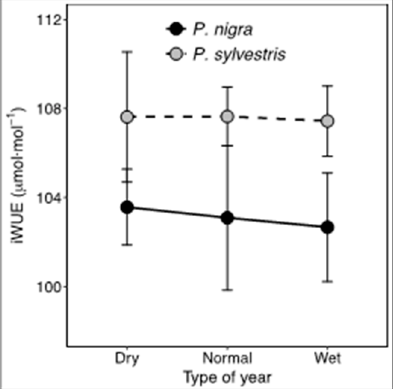
Figure 6. Mean intrinsic water use efficiency (iWUE) for dry, average, and wet years. Each point is the mean of values for three years in five trees per species. Error bars represent the standard error of the mean. Forests 2017 , 8 , 332